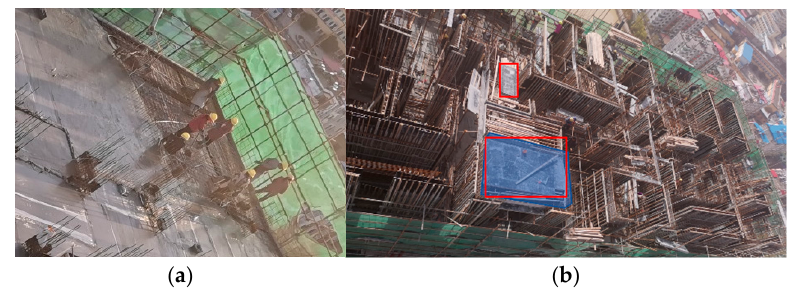
Figure 12. Reasoning error cases: ( a ) End of concreting; ( b ) Start of formwork for